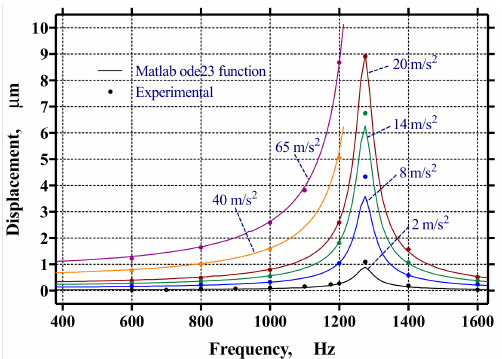
Figure 14. Resulting amplitude sensor response.